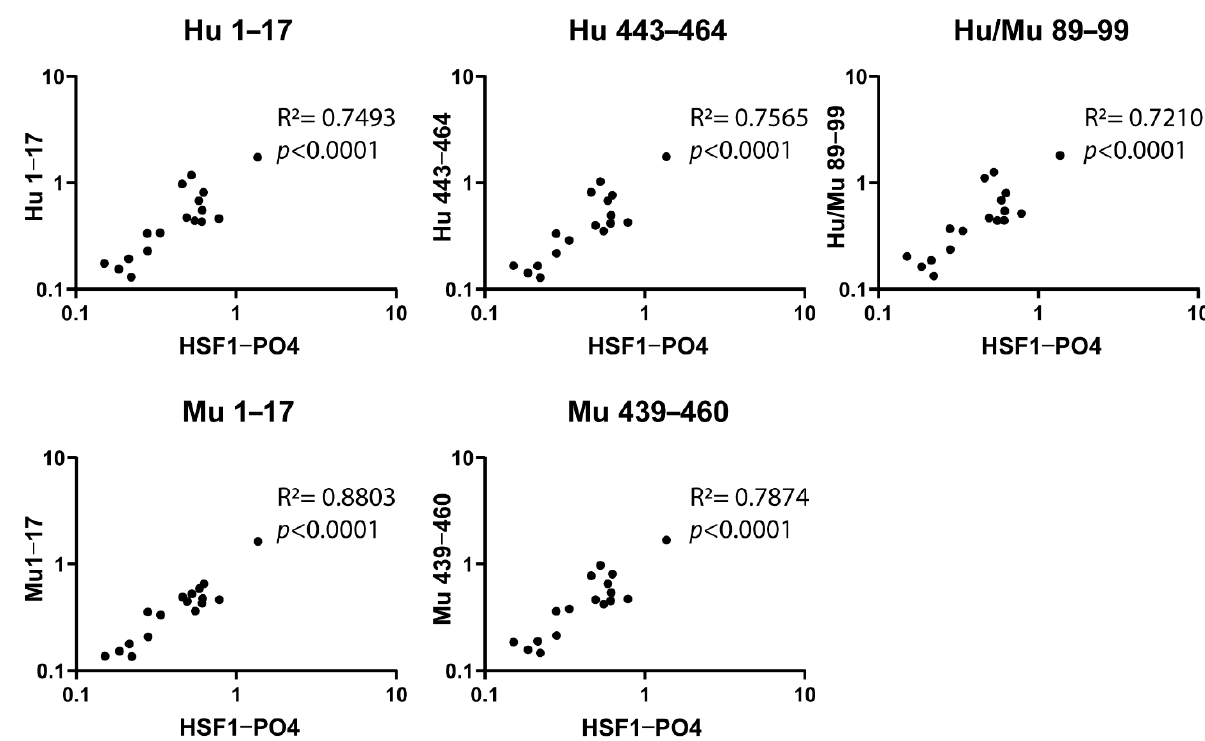
Figure 2. IgA-specific antibodies to HSF1-PO4 and the individual selected epitopes, were measured by indirect ELISA. Plasma samples (diluted 1:20) from control samples ( n = 10) and early-stage HGSOC patients ( n = 7), were analysed in duplicate. Associations between responses were analysed using Pearson’s R correlation (R 2 ), following log transformation to establish normality (data found in Supplementary Table S1). Individual OD values plotted on a log scale.